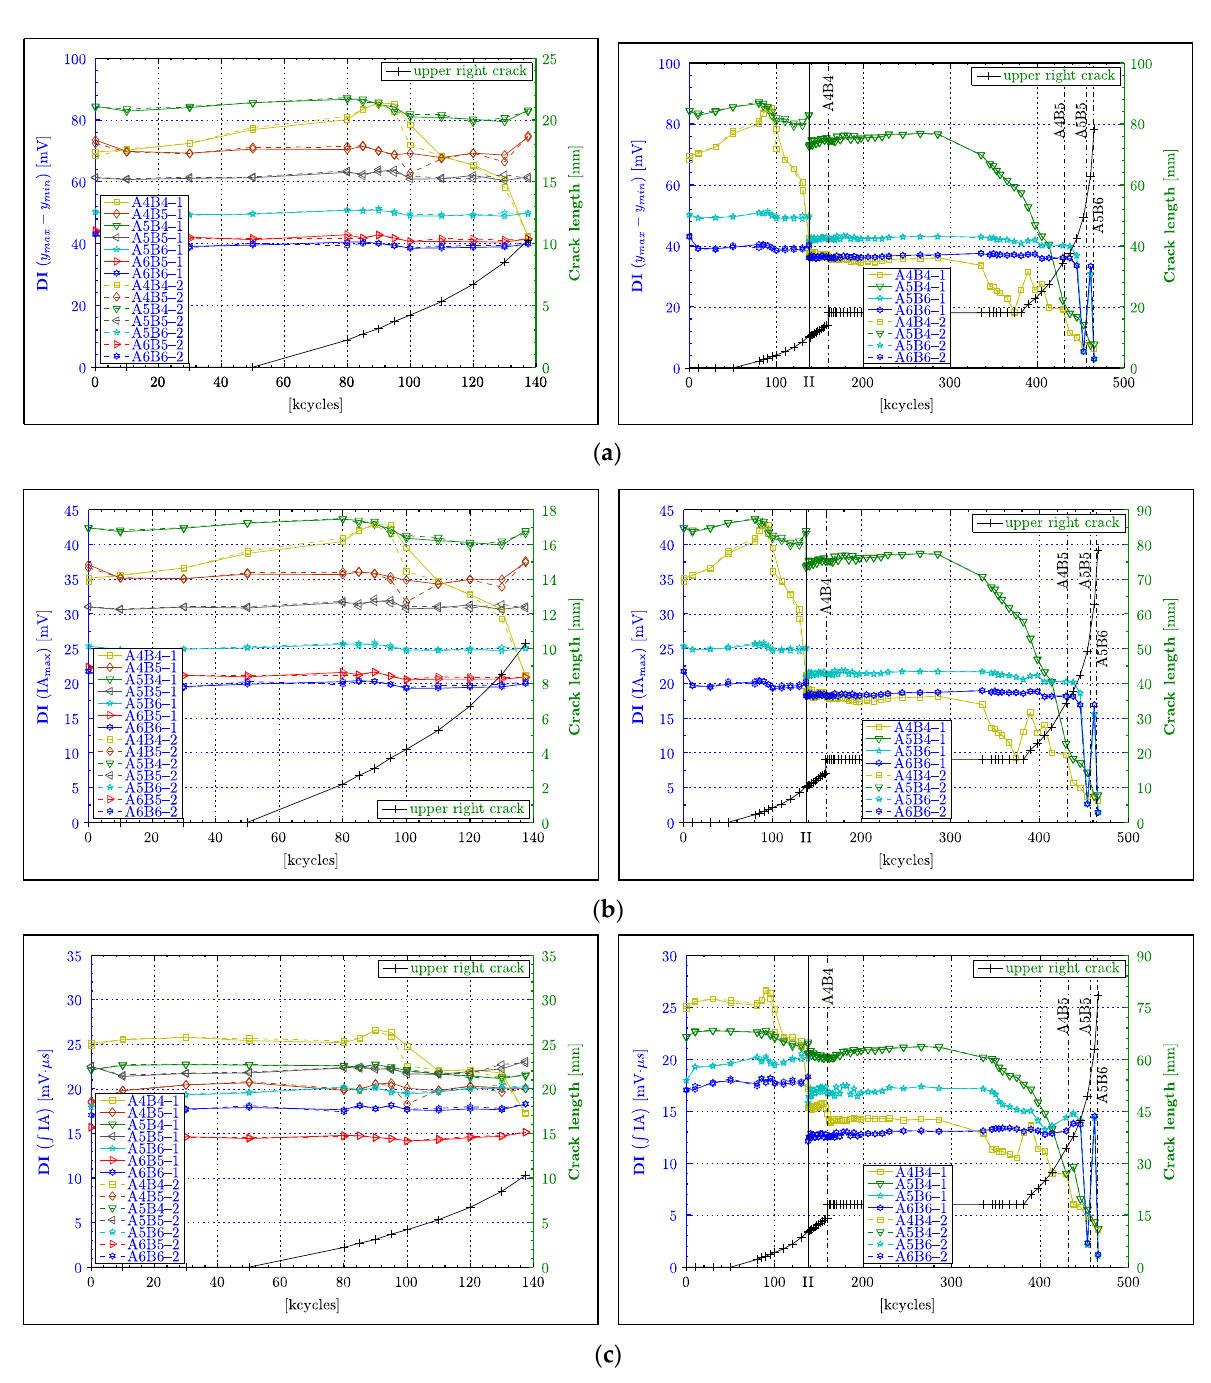
Figure 8. Crack detection results for the LEFT wave propagation paths. Damage indices are based on: ( a ) maximum peak-to-peak amplitude; ( b ) maximum instantaneous amplitude (envelope); ( c ) integrated instantaneous amplitude. The left column gives the results corresponding to only the PHASE 1 experimental test (from 0 to 147,500 fatigue cycles only) whereas the right column presents the results for the PHASE 1 and PHASE 2 experimental tests.